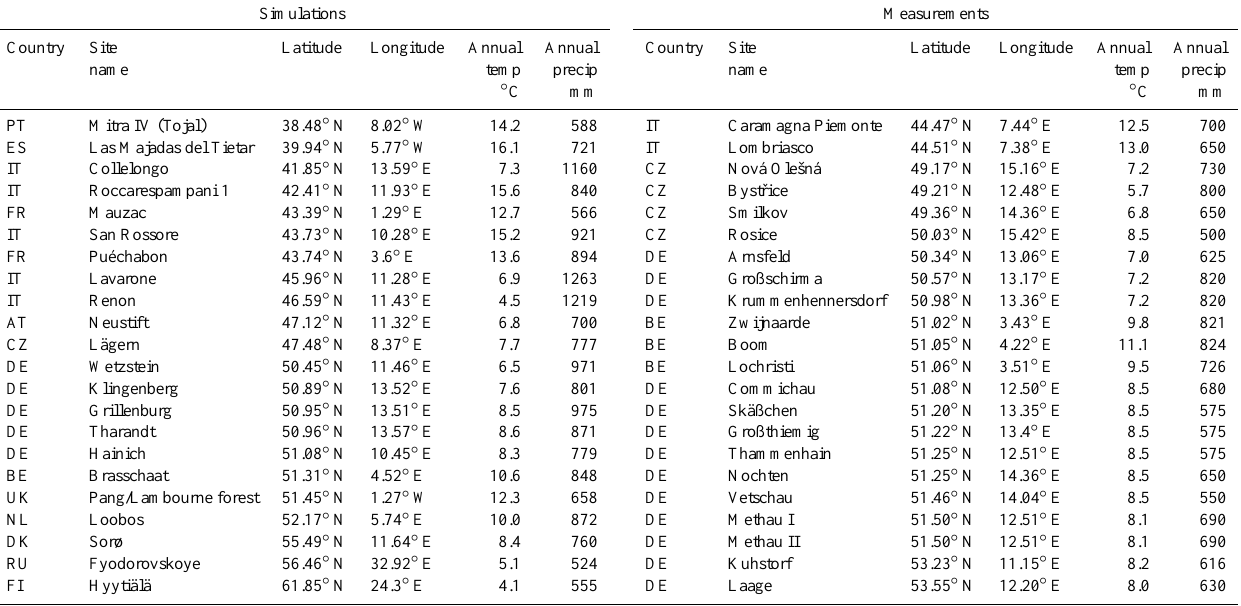
Table 3. Biomass validation site info for the simulated sites, acquired from the European Fluxes Database Cluster (http://gaia.agraria.unitus. it/, 1 September 2014) and the measured sites, acquired from Njakou Djomo et al. (2015).